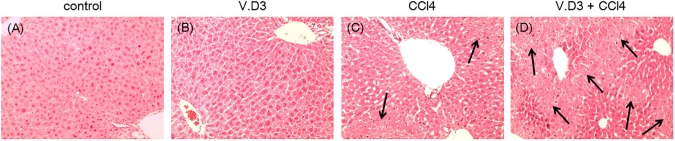
Pretreatment with V.D3 becomes worse animals from acute CCl4-induced hepatotoxicity, as assessed by H&E staining.Mice were treated as described in legend for Fig 2. At 24 h after CCl4 injection, animals were euthanized and livers were harvested at necropsy. Liver specimens were fixed and processed by standard methods, and sections were stained with H&E (A–D). Micrographs provide 10× magnified images of representative H&E-stained liver sections obtained from the control (A), V.D3 (B), CCl4 (C), and V.D3 + CCl4 (D) groups. Black arrows indicate area of necrosis.